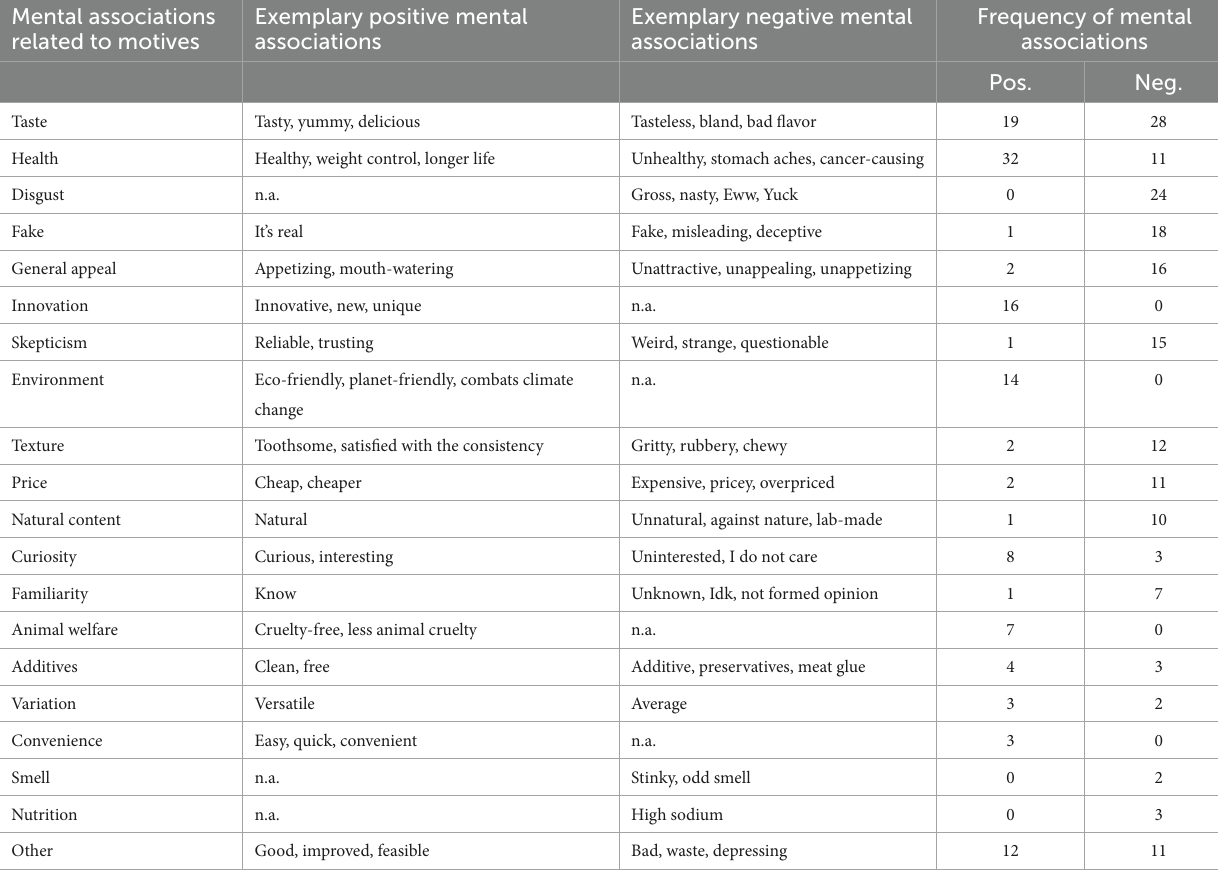
TABLE 2 Mental associations reflecting motives and barriers for meat substitute consumption. Mental associations related to motives